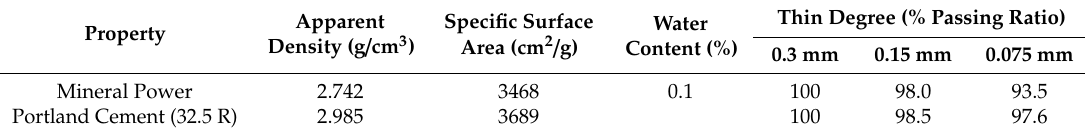
Table 5. Basic properties of mineral powder and Portland